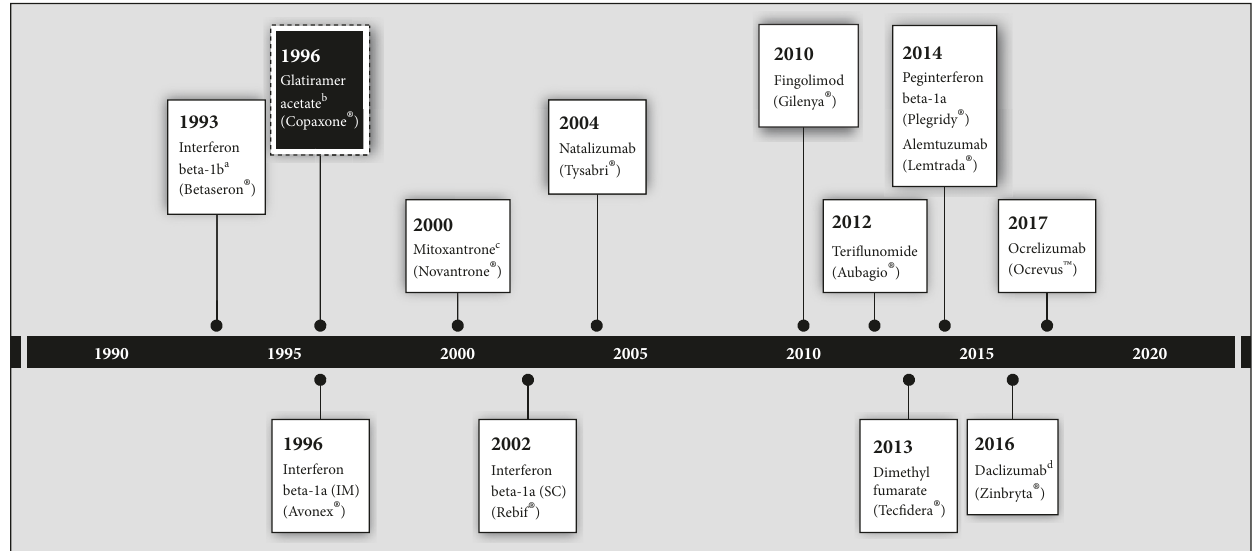
Figure 1: Timeline of approval by the FDA of disease-modifying therapies for multiple sclerosis. FDA: Food and Drug Administration; IM: intramuscular; SC: subcutaneous. a Interferon beta-1b was also approved in 2009 as Extavia (cid:2) (which is the Novartis-branded version of the Bayer product Betaseron (cid:2) ). b Various generic versions of glatiramer acetate are in development. Glatopa (cid:3) [10] was approved in 2015 by the FDA. Other generic versions were approved in the EU in 2016 and by the FDA in 2017 [11, 12]. c Bioequivalent generic mitoxantrone was approved in 2006. d Subsequently withdrawn (March